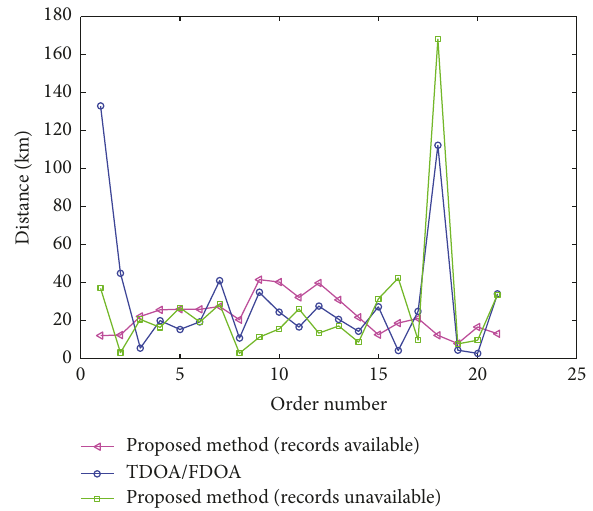
Figure 8: Distance between reference positions and estimated